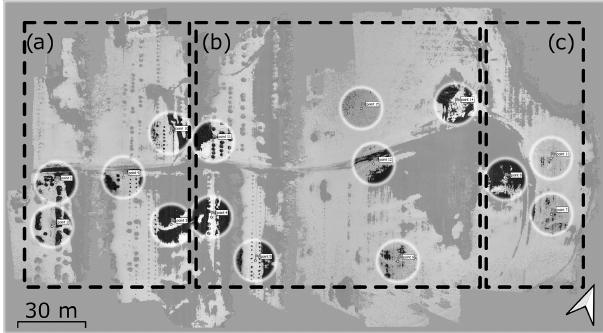
Figure 4. Accuracy test experimental setup: (a) typical, (b) middle, (c) end.